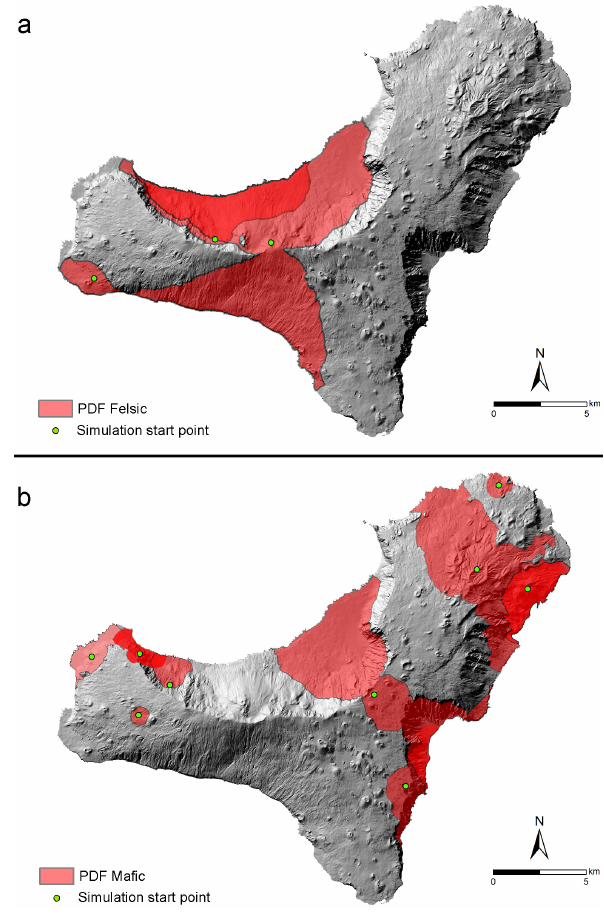
Figure 5. PDC scenarios performed with VORIS 2.0.1. Covered ar- eas with different collapse equivalent heights ( H c ), collapse equiv- alent angles ( θ ) and VEI values (see the text for more detail). (a) VEI 2 corresponding to felsic eruptions; (b) VEI 1 correspond- ing to mafic